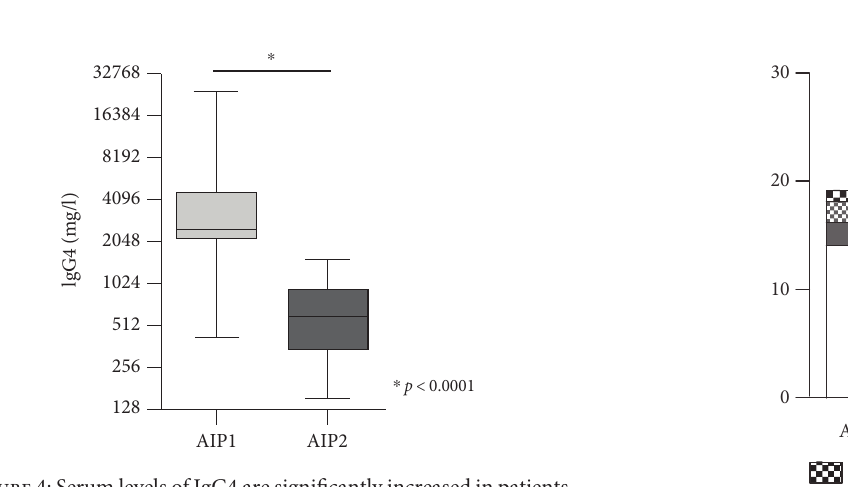
Figure 3: Cholestatic liver enzymes in patients with AIP1 and AIP2. (a) Total bilirubin is signi fi cantly increased in patients with AIP1 as compared to patients with AIP2. Likewise, AP (b) and γ -GT (c) were signi fi cantly elevated in patients with AIP1.